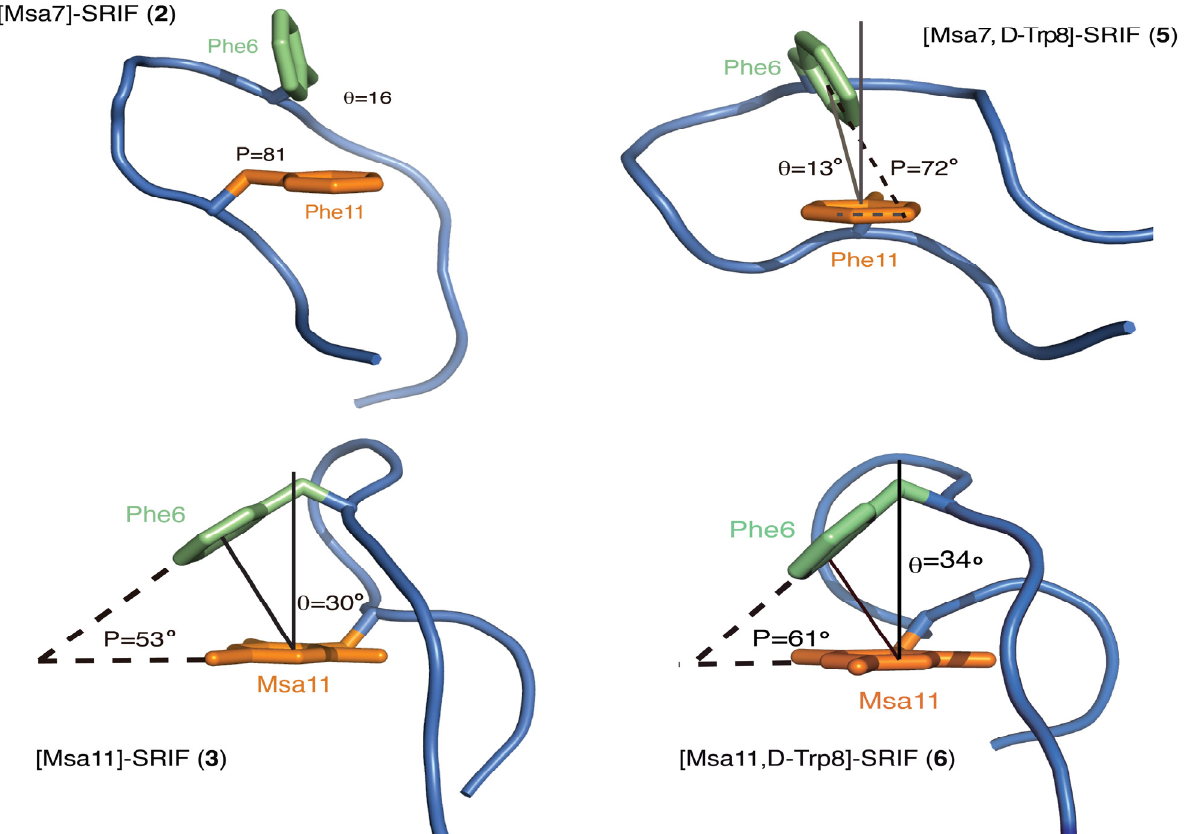
Figure 7. Schematic representation of the aromatic interactions in peptides 2 , 3 , 5 and 6